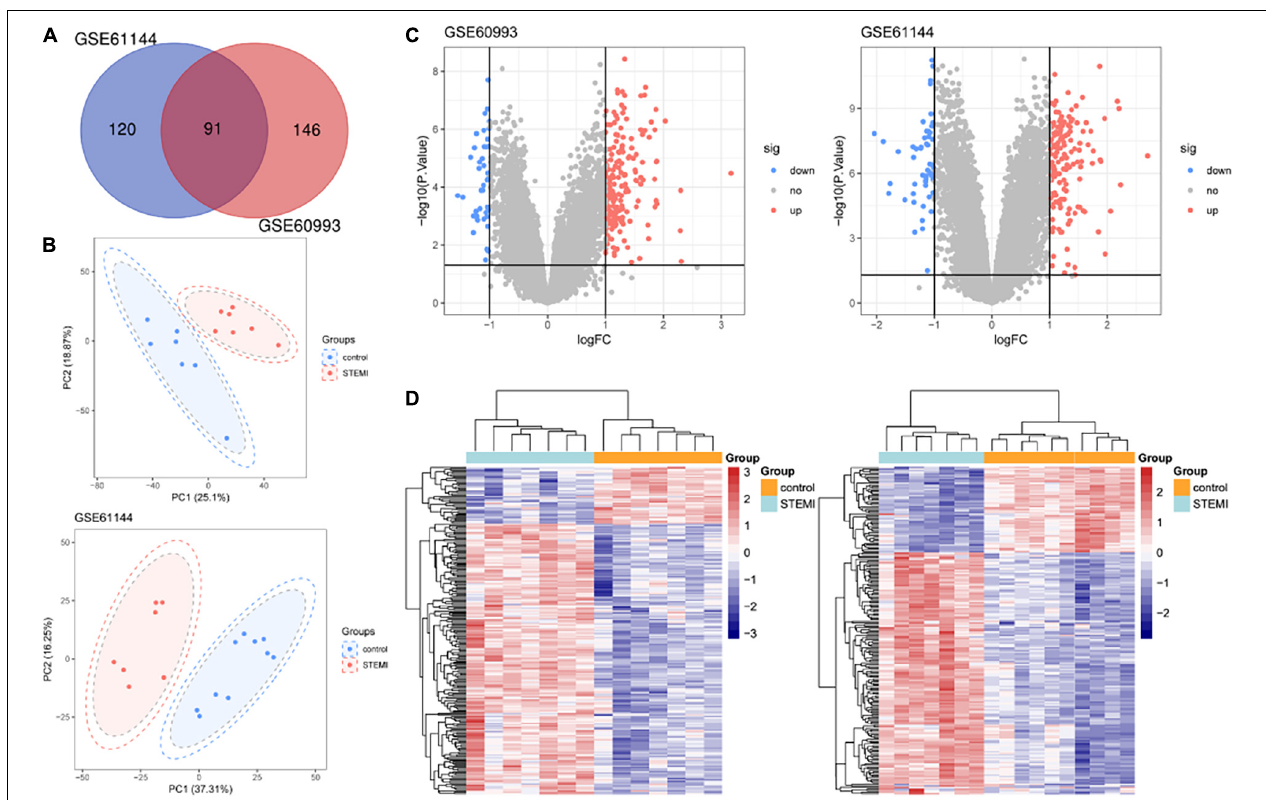
FIGURE 1 | Transcriptome of peripheral blood analysis in GSE61144 and GSE60993 microarray. (A) Venn diagram of 91 DEGs from two microarray datasets. (B) PCA score plots of STEMI group and healthy control group in these two datasets. (C) The volcano plots of DEGs in two datasets. Red indicates genes with high levels of expression, blue indicates genes with low levels of expression, and gray indicates genes with no differential expression based on the criteria of P < 0.05 and |logFC| > 1.0, respectively. (D) Heatmap of DEGs in two microarrays showed hierarchical clustering of changed transcription of genes in a clustering analysis in different groups. PCA, principal component